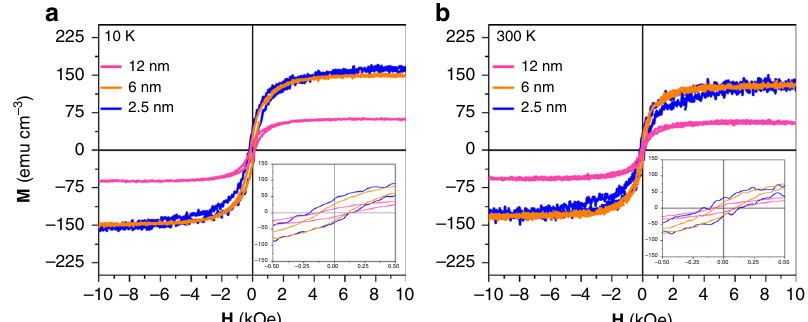
Fig. 4 Observation of ferromagnetism. Magnetization vs. fi eld hysteresis curves with an in-plane fi eld orientation for 2.5, 6, and 12 nm of Ru at a 10 K and b room temperature, with the inset for each showing a zoom in near the coercive fi eld